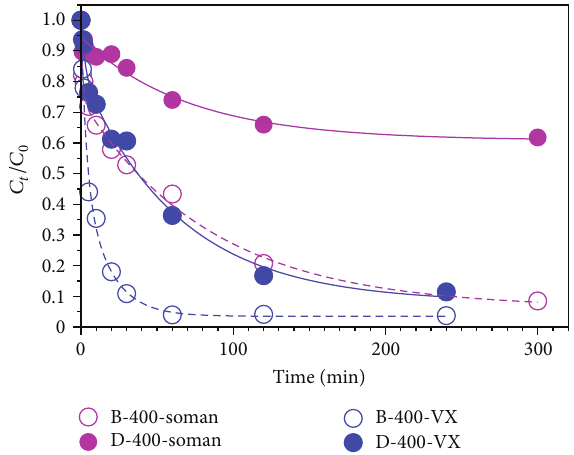
Figure 6: Time dependencies for the degradation of nerve agents VX and soman using recovered (solid symbols, bold lines) and pure (open symbols, dashed lines) cerium